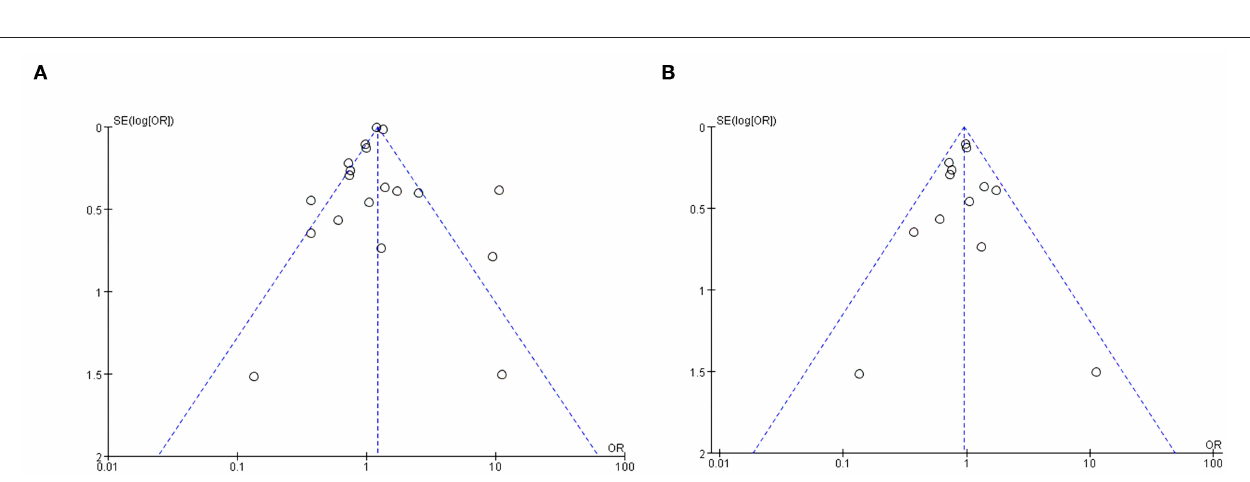
FIGURE 3 | The funnel plots of all included trials: the considerable heterogeneity of included trials (A) and lowering heterogeneity through six trials exclusion (B) .